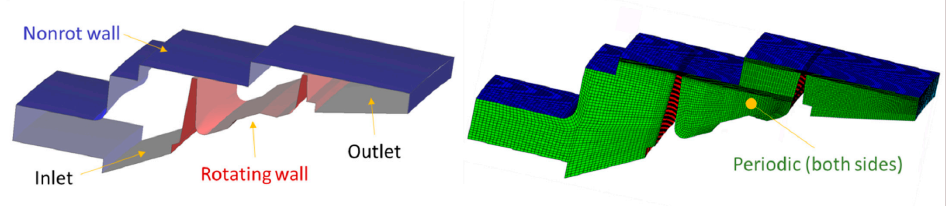
Figure 2. OAS model, boundary conditions, and